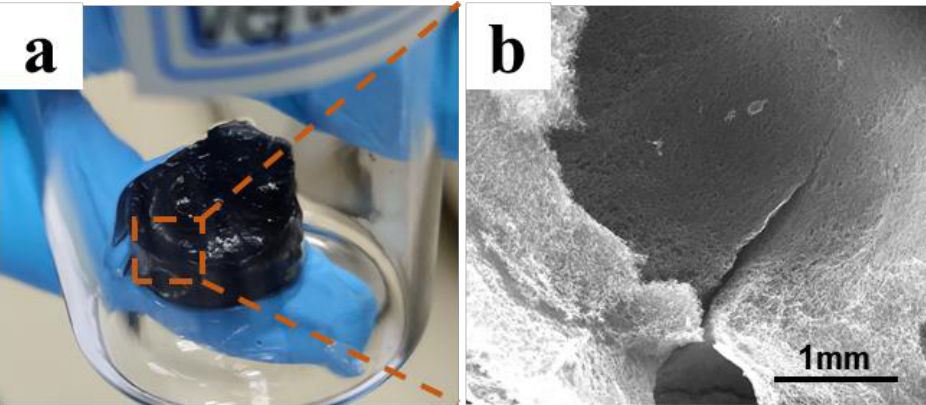
Figure 5. Pore and cracks in the gel after hydrothermal reduction at 100 °C: ( a ) surface of the gel; ( b ) inner surface of the pores.